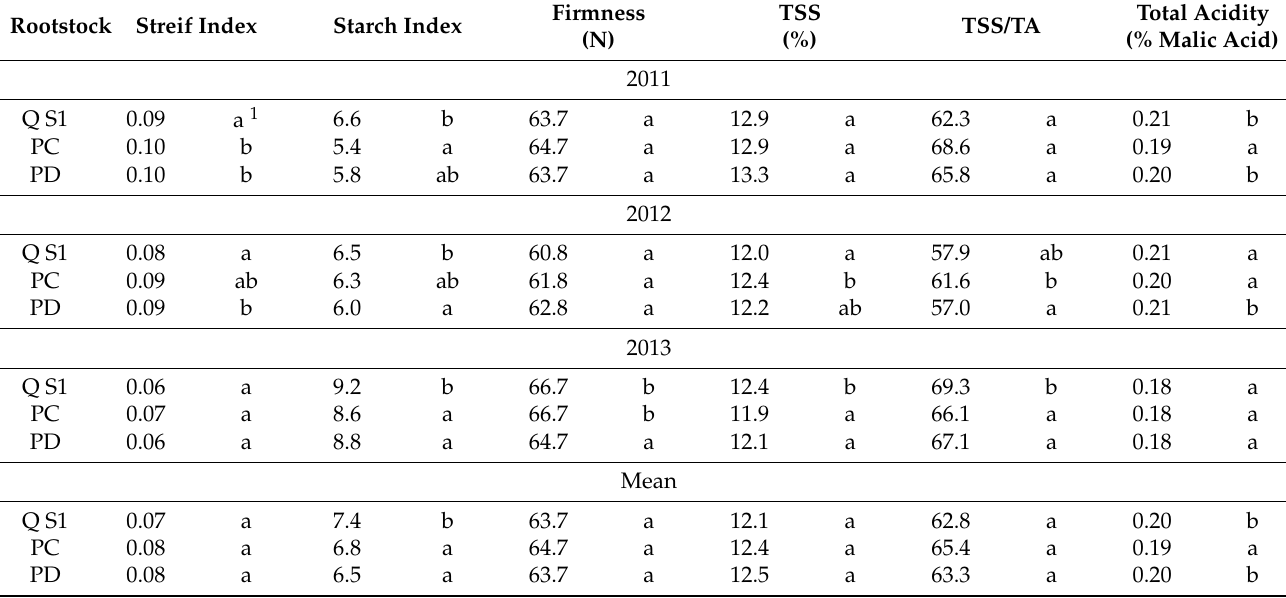
Table 1. The influence of rootstock on the quality parameters of pears at harvest in 2011–2013. Rootstock Streif Index Starch